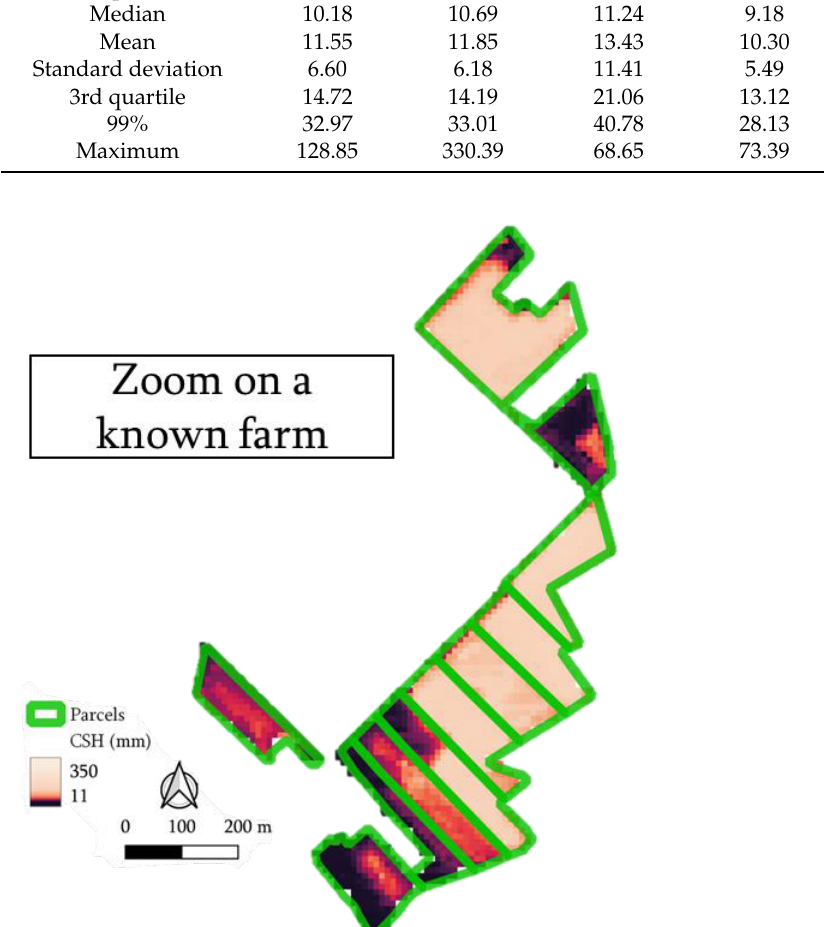
Figure 7. Geographical representation of the predictions for parcels on a farm known by our team.